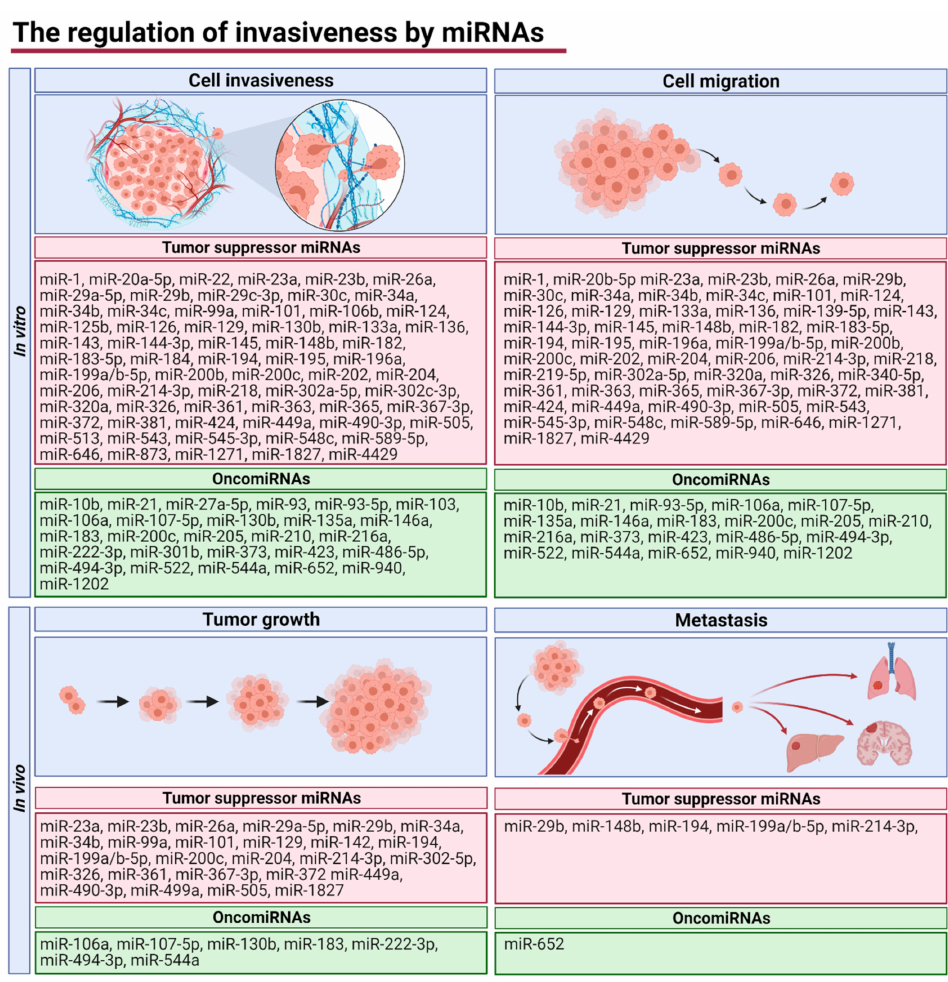
Figure 3. miRNAs regulating cell invasiveness and cell migration in vitro as well as tumor growth, and metastasis in vivo. Figure was created using Biorender.com. Table 3. The role of miRNAs in invasion and metastasis in vitro and in